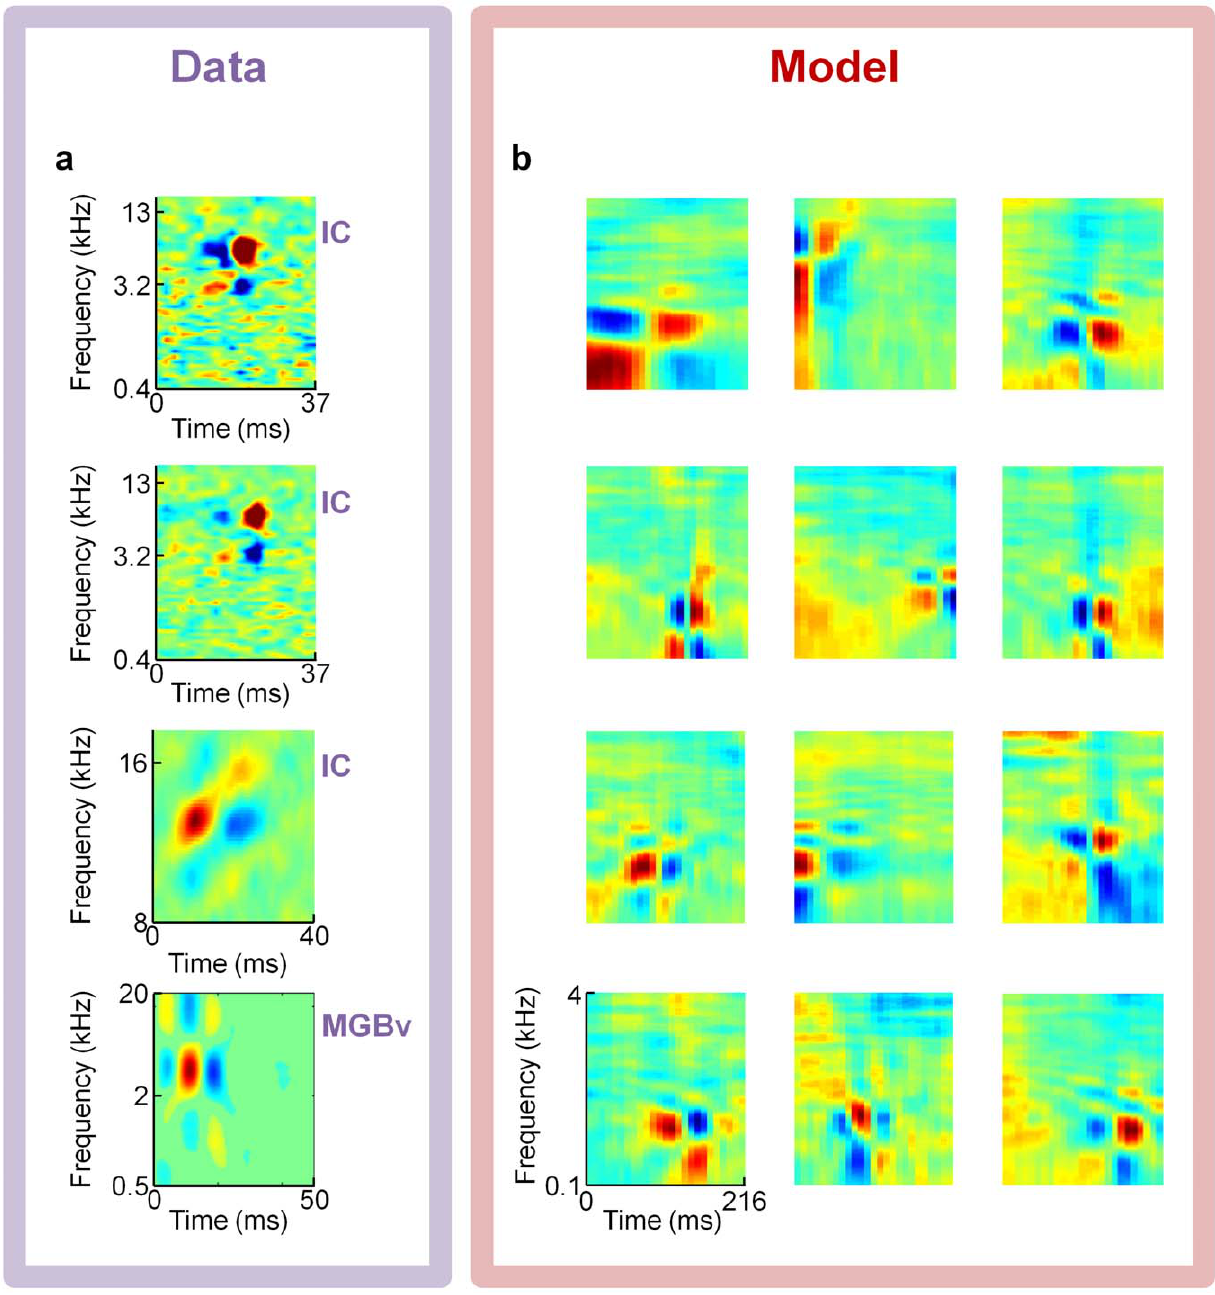
Figure 7. Model comparisons to receptive fields from auditory midbrain and thalamus. An overcomplete sparse coding model trained on spectrograms of speech predicts Inferior Colliculus (IC) and auditory thalamus (ventral division of the medial geniculate body; MGBv) spectro- temporal receptive fields (STRFs) consisting of localized checkerboard patterns containing roughly four to nine distinct subfields. ( a ) Example STRFs of localized checkerboard patterns from two Gerbil IC neurons [31], one cat IC neuron [33], and one cat MGBv neuron [34] (top to bottom). Data courtesy of N.A. Lesica (top two cells) and M.A. Escabı´ (bottom two cells). ( b ) Elements from the four-times overcomplete, L0-sparse, spectrogram- trained dictionary with similar checkerboard patterns as the neurons in panel a